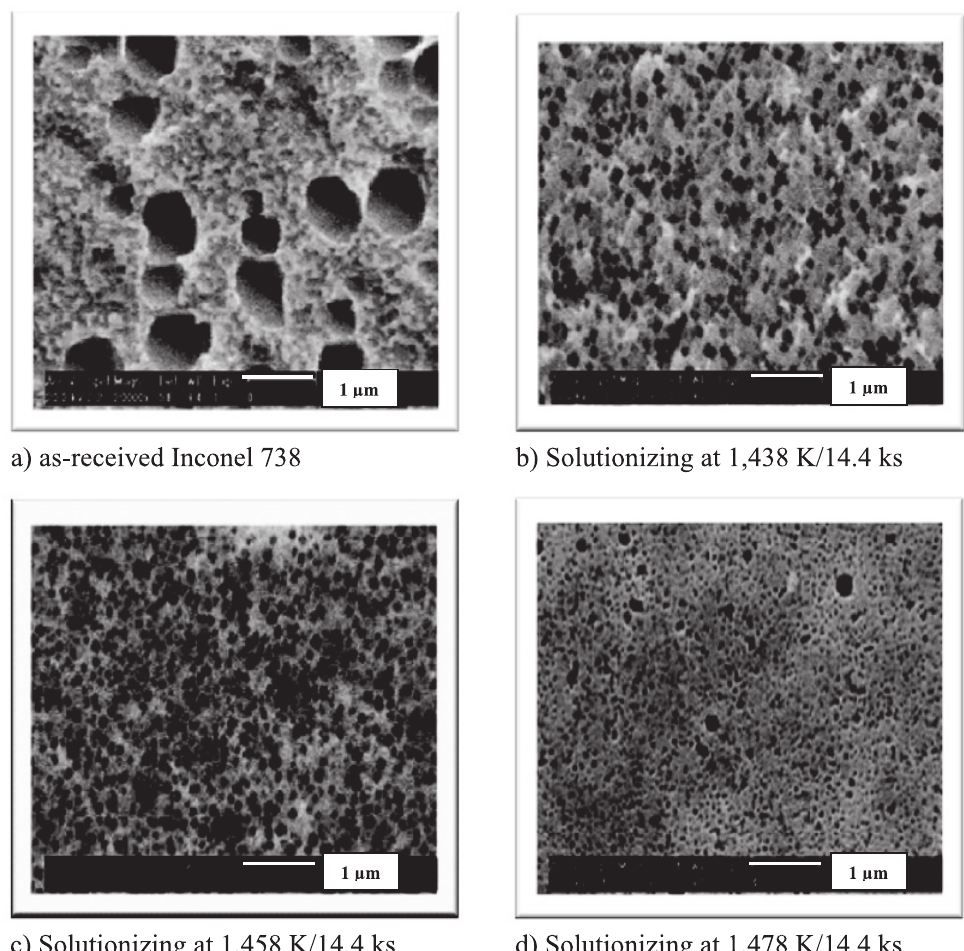
Fig. 1: Microstructures of Inconel 738 from various conditions observed by